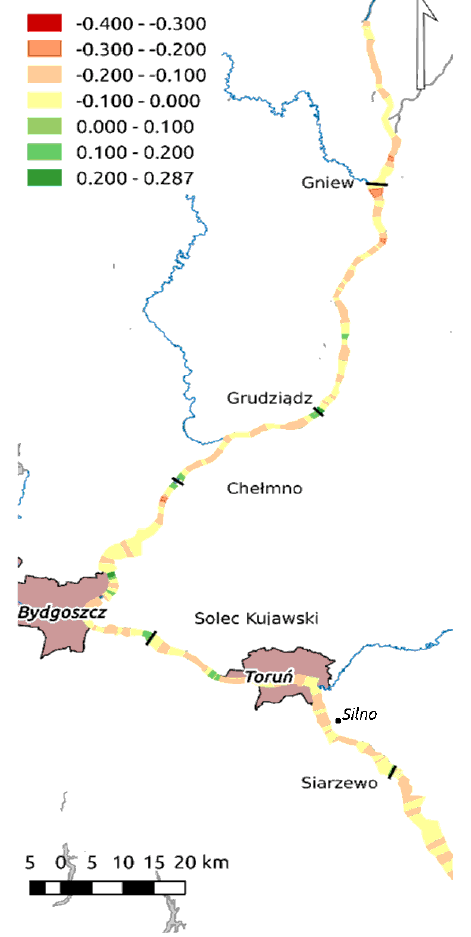
Figure 10. Predicted changes in the channel volume (mln m 3 ) of the Lower Vistula with cascade, comparing to the scenario when cascade is not being developed. The channel volume, as the volume of water above the bed, was calculated between computation cross sections.